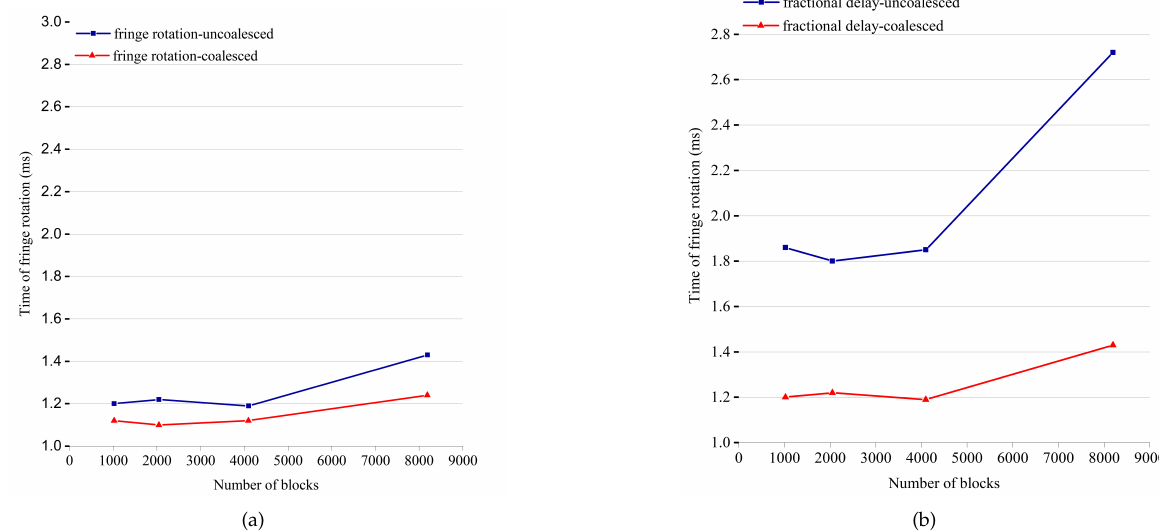
Figure 8. The thread allocation optimization under different number of blocks. ( a ) Fractional delay. ( b ) Fringe